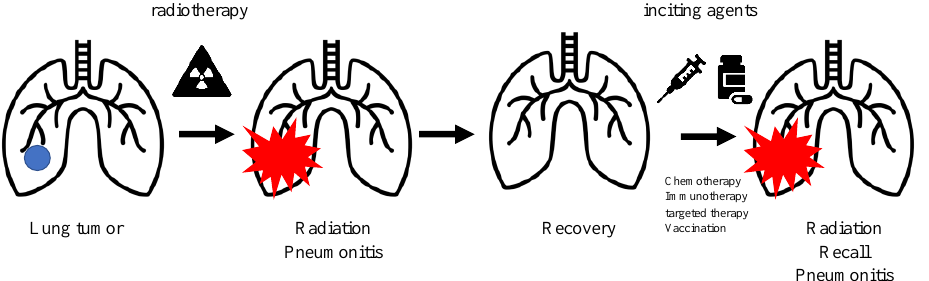
Figure 1. Radiation pneumonitis (RP) commonly occurs in patients treated with radiotherapy to the lung. After recovery from RP, recall radiation pneumonitis (RRP) may occur in the previously irradiated lung of patients with cancer after administering inciting agents, including chemotherapy, targeted therapy, immunotherapy, and vaccination.